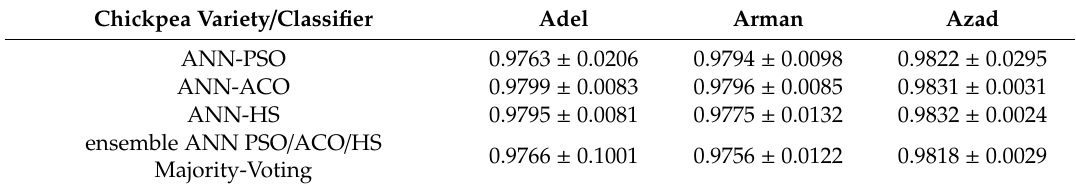
Table 10. Mean ± std. AUC values for the precision-recall curves(pr-AUC): ANN-PSO,